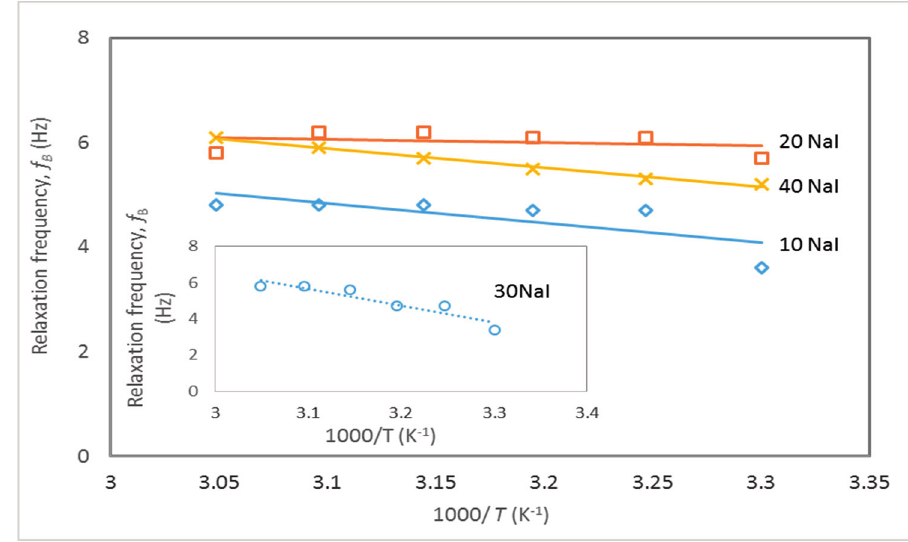
Figure 5. Temperature dependence of the relaxation frequency of the bulk conductivity ( f B ) of P(MMA- co -EMA) + NaI at different